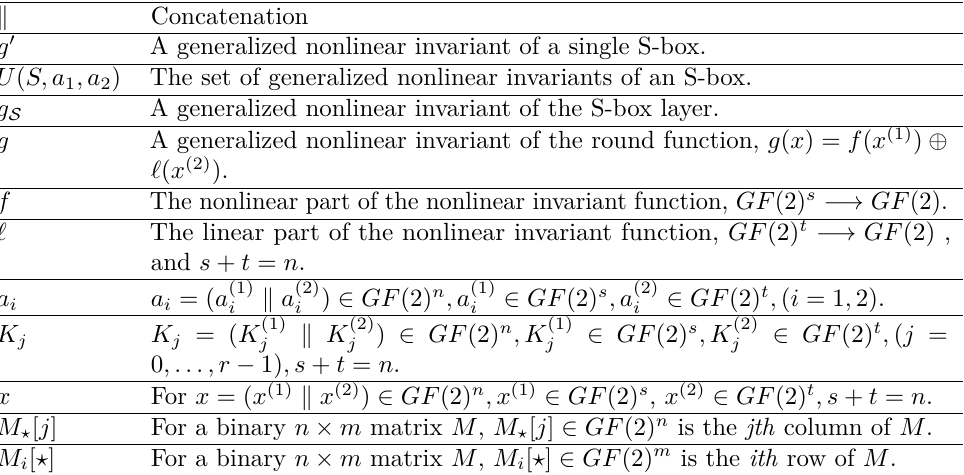
Table 1: The notation used throughout the